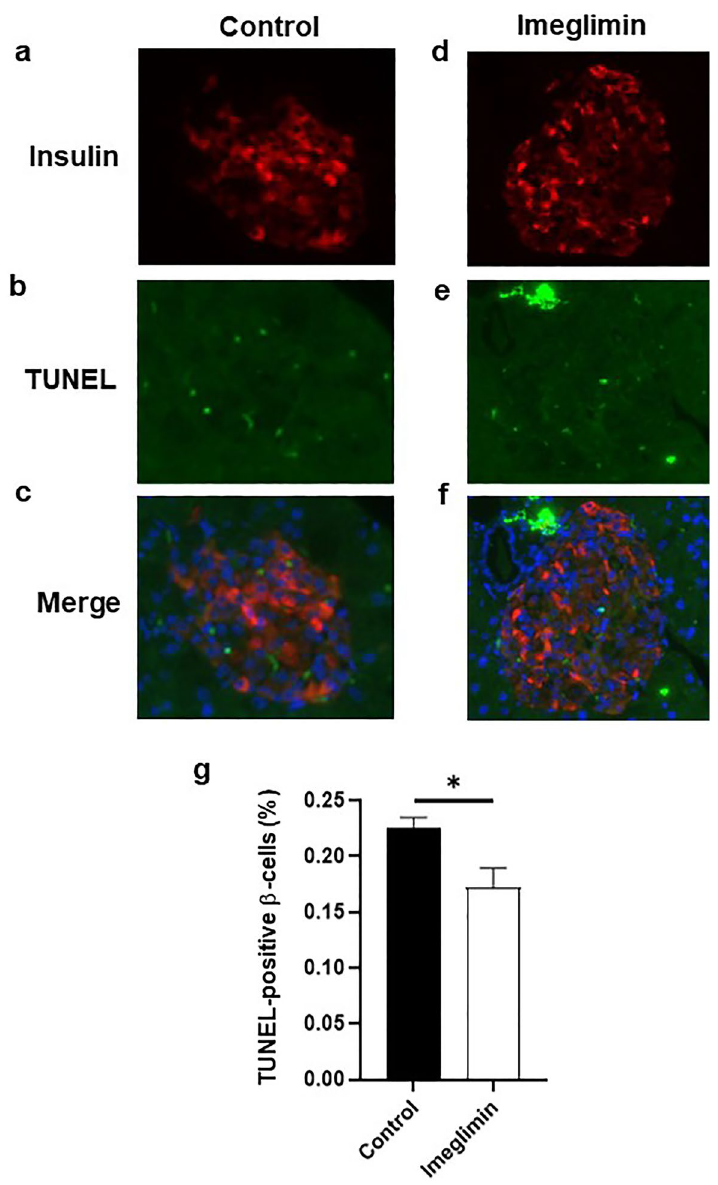
Figure 4. Effects of chronic administration of imeglimin on apoptosis in pancreatic β-cells in obese type 2 diabetic db/db mice. ( a – f ) In immunostaining with insulin and TUNEL, TUNEL-positive β-cells were more often observed in the mice without treatment with imeglimin compared to those with the treatment. ( g ) Quantitative evaluation about the effects of imeglimin on the percentage of TUNEL-positive β-cells (n = 5–6). ( h – l ) Expression levels of apoptosis- and inflammation-related genes in db/db mice after 4-week treatment with imeglimin. Expression levels of caspases, inflammatory cytokines and NLRP-3 were all significantly lower in the mice treated with imeglimin (n = 9). ( m – n ) Effects of imeglimin on oxidative stress in db/db mice. Level of urinary 8-OHdG was lower in diabetic db/db mice treated with imeglumin compared to those without the treatment (n = 4–5). Values are the mean ± SEM of data obtained from each group. * p <